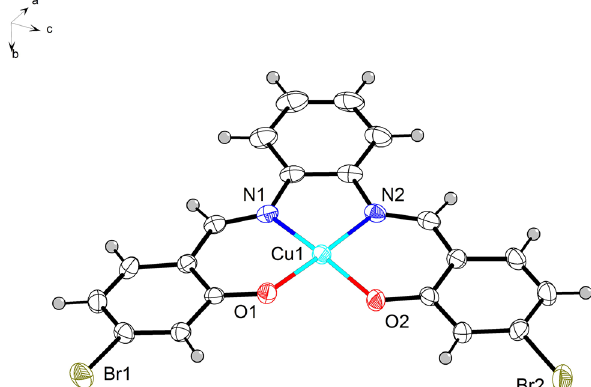
Table 1 contains crystallographic data and Table 2 contains the list of the atoms including atomic coordinates and displacement parameters.